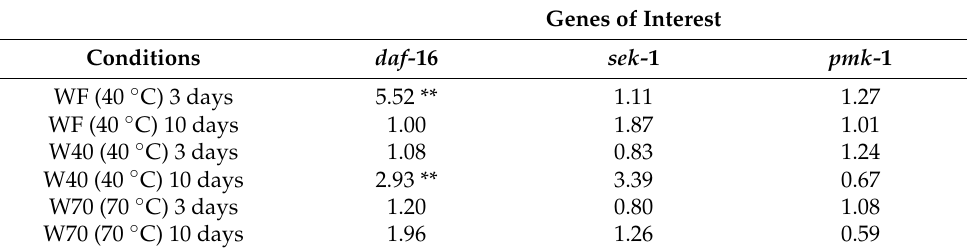
Table 6. The relative expression of the three C. elegans genes of interest after 3 days or 10 days of incubation on a medium supplemented with aqueous extracts WF, W40 or W70, in comparison with CC1 condition. The expressions were considered significantly different when the p -value was lower than 0.01 (**), and simultaneous when the expression change was of at least 2 times higher or 0.5 times lower.